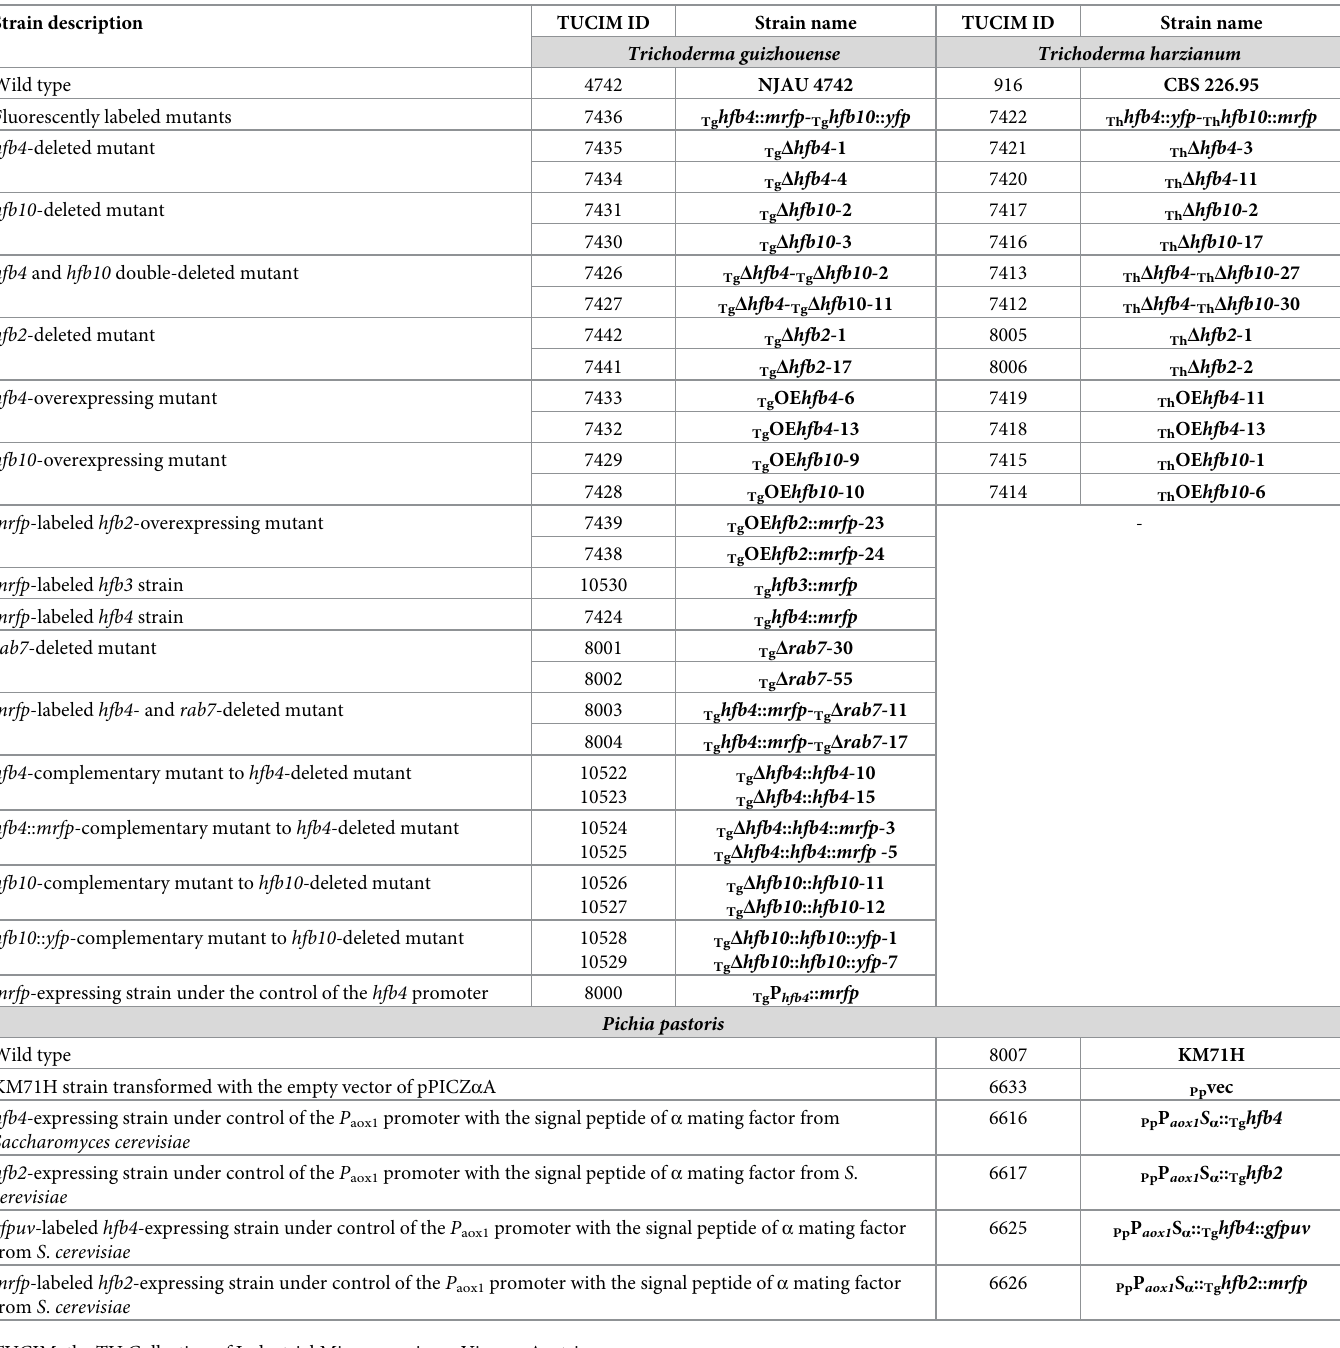
Table 2. Strains used in this